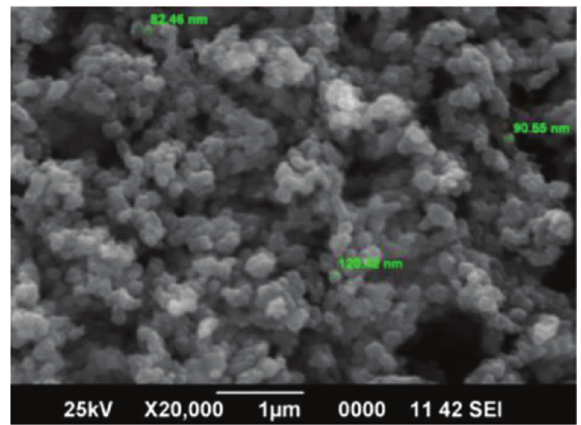
Figure 2: Typical SEM image of ZnO of approx. 10 × 10 − 2 µ m-size